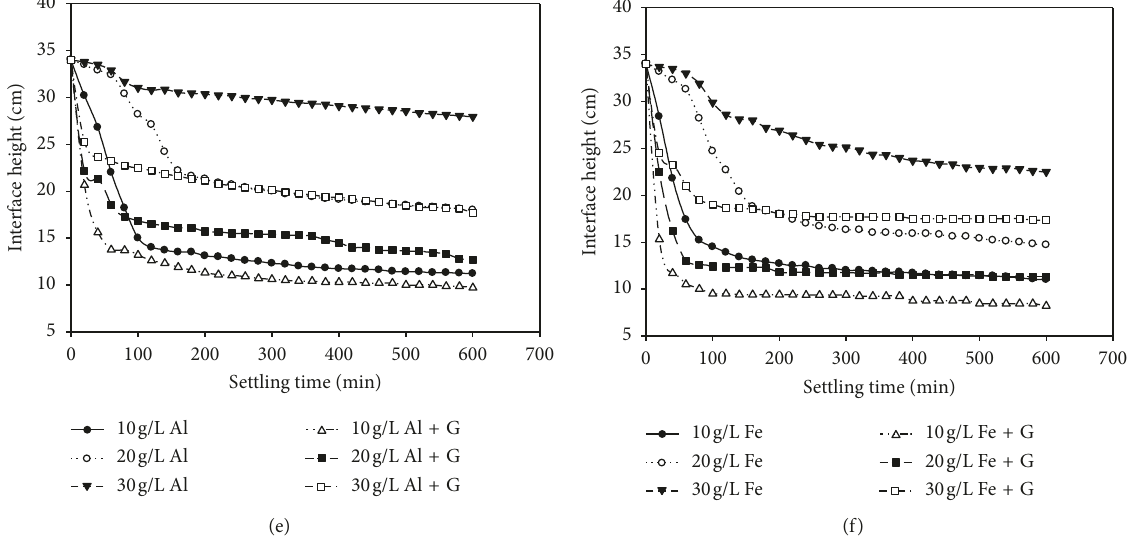
Figure 6: Settling curves of coagulated laterite suspension: pH 5 (a–c); pH 7 (d–f); Al (alum); Fe (FeCl spp. biopolymer); Fe+G (FeCl 3 +25mg/L Grewia spp. biopolymer).